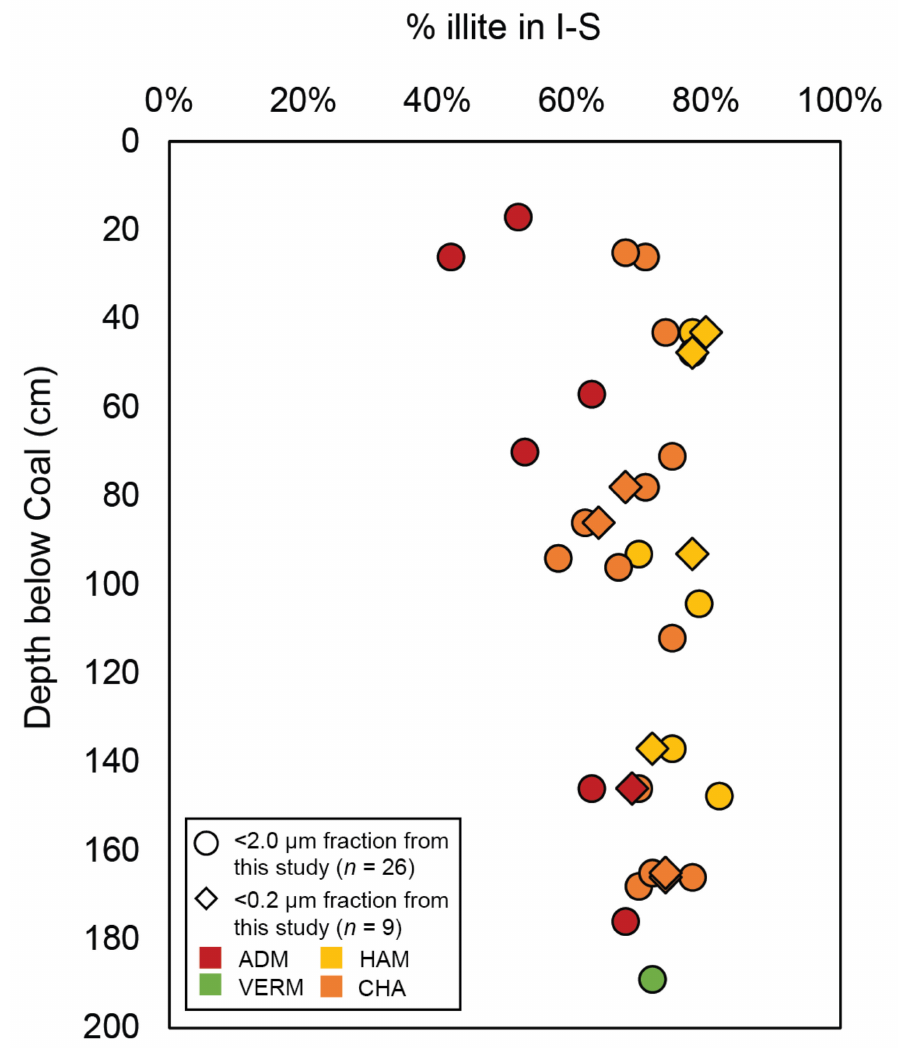
Figure 10. % illite in I-S of the <2.0 and <0.2 µ m clay-sized fraction of paleosol matrices relative to depth below coal seam for paleosols directly underlying coals ( ntot = 35). See Table 4 for tabulated data and information about specific IB